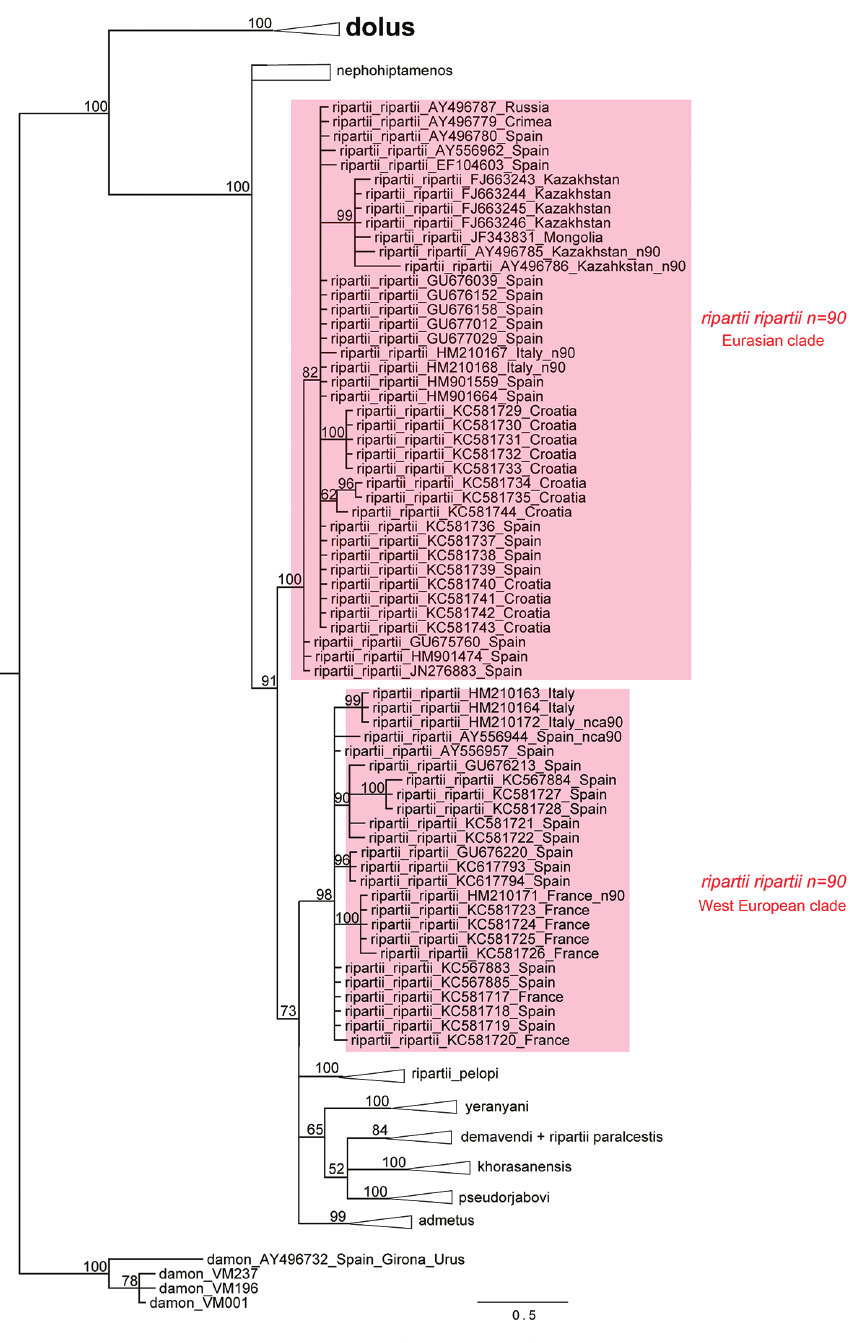
Figure 7. Fragment of the Bayesian tree of P. admetus and P. dolus complexes based on analysis of COI barcodes and focused on details of the West-European and the “mixed” (Eurasian) clades of P. ripartii . Numbers at nodes indicate Bayesian posterior